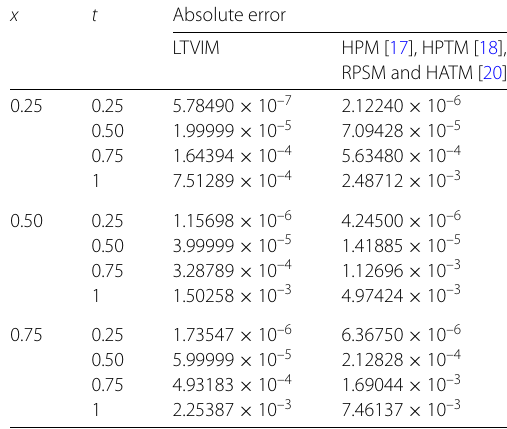
Table 1 Comparison of LTVIM, HPM [17], HPTM [18], RPSM, and HATM [20] on Example 4.1. Here α = 1 is used for all